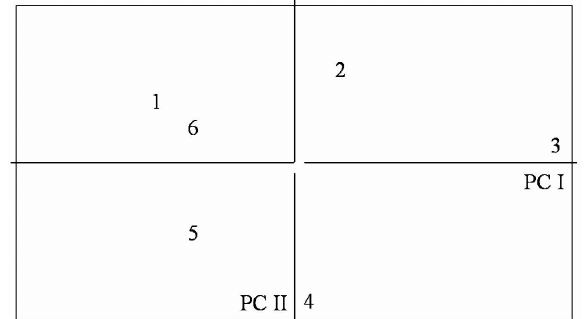
Fig . 3. – Scores of microsatellite genotypes plotted on the first two axes (PC-I and PC-II) of a principal component analysis performed using pca-gen. 1, Exe; 2, Teign; 3, Tamar; 4, Looe; 5, Camel; 6,